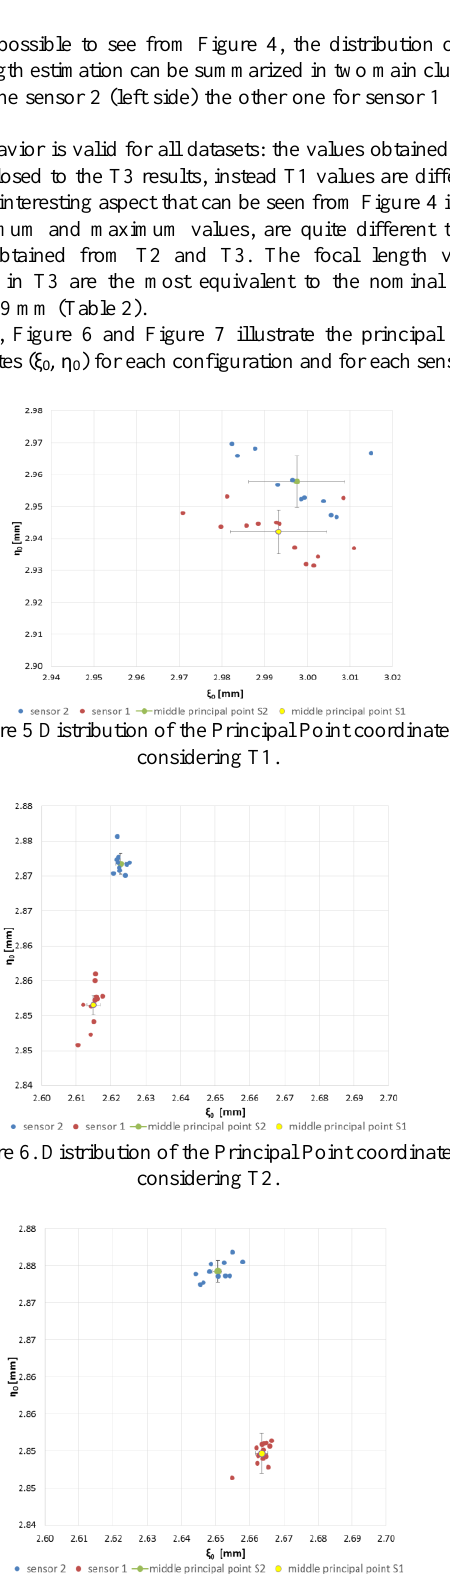
Figure 7. Distribution of the Principal Point coordinates considering T3